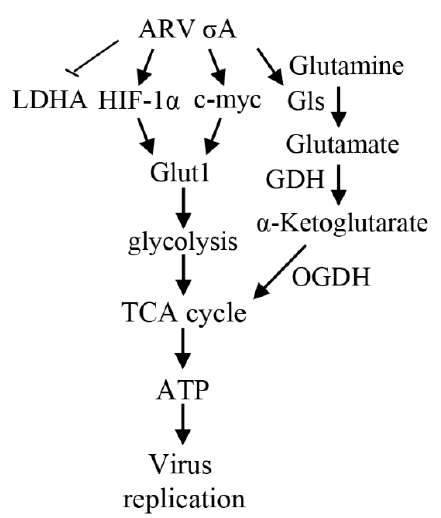
Figure 8. A model depicting that ARV σ A enhances glycolysis and glutaminolysis to produce energy via the HIF-1 α /c-myc/glut1 pathway to benefit ARV replication in A549, B16-F10, and HeLa cancer cell lines. → : activation; ⊥ : inhibition. GDH: glutamate dehydrogenase [16]. Supplementary Materials: The following supporting information can be downloaded at: https://www.mdpi.com/article/10.3390/v15020523/s1. Figure S1: Oncolytic ARV replication in cancer cell lines HeLa, A549, and B16-F10; Figure S2: Quantification of Western blot results; Figure S3: Cell viability in three cancer cell lines; Figure S4: ARV infection and σ A shRNA transfection alter levels of c-myc, HIF-1 α , and glut1 in three cancer cell lines; Figure S5: ARV p17 downregulates the levels of c-myc, HIF-1 α , and glut1 in three cancer cell lines; Figure S6: Confirmation of the expression levels of ARV σ A protein; Figure S7: Quantification of signals in Western blots; Figure S8: Quantification of ATeams by fluorescence density analysis; Figure S9: Quantification of signals in Western blots; Figure S10: All original uncropped